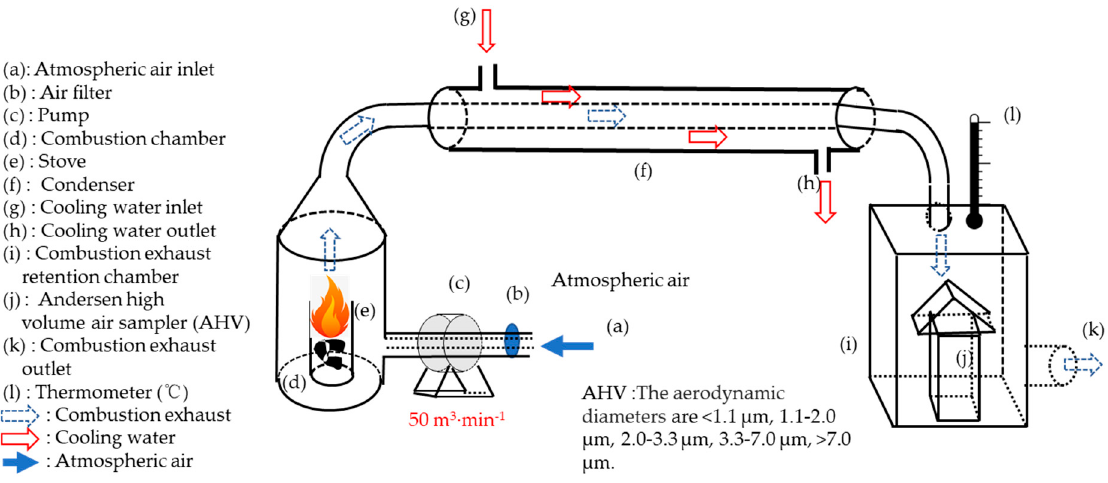
Figure 3. Sketch of sampling system.